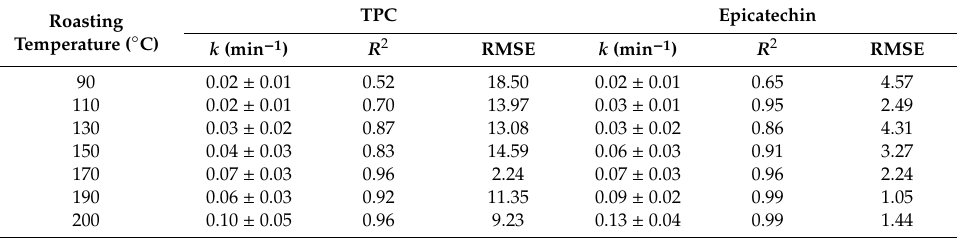
Table 2. First-order kinetic parameters fitted for TPC and epicatechin degradation.